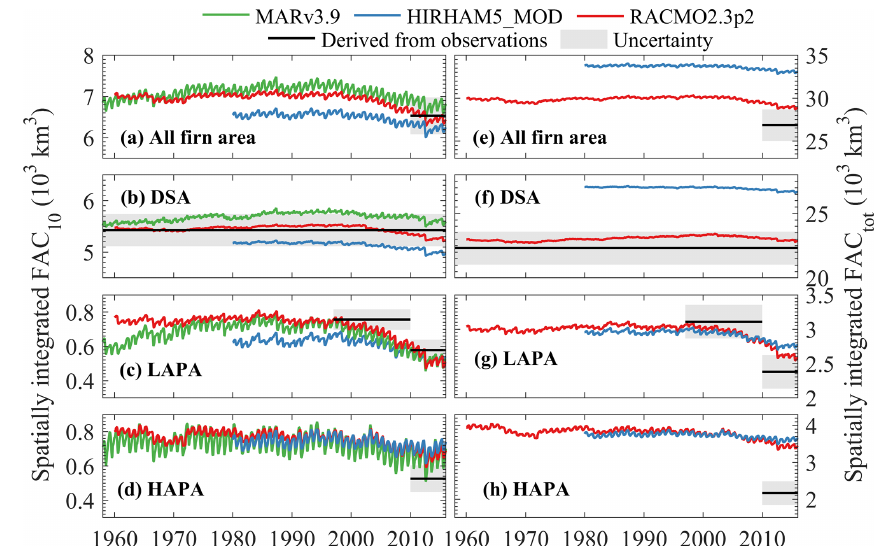
Figure 7. Spatially integrated FAC in the RCMs and from observation-derived